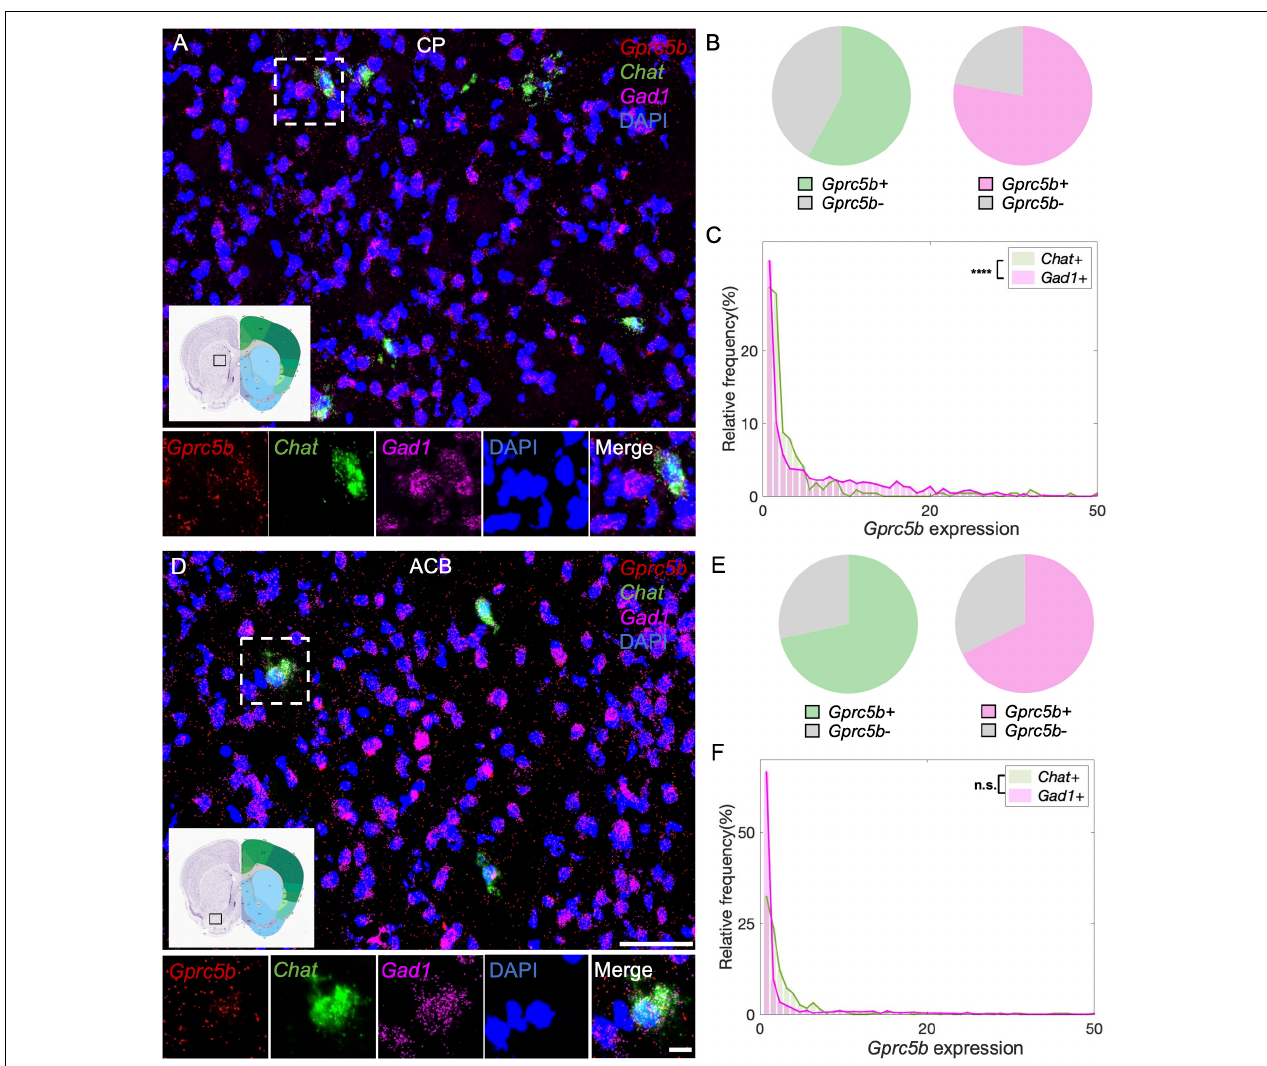
FIGURE 8 | Striatal Gprc5b mRNA distribution within cholinergic interneurons and GABAergic medium spiny neurons. Representative in situ hybridization images showing Gprc5b mRNA distribution in CP (A) and ACB (D) . Gprc5b is in red, cholinergic interneurons marked by Chat probe in green, GABAergic MSNs indicated by Gad1 probe in magenta, nuclei by DAPI in blue. Pie charts showing percentage of Gprc5b positive cells within cholinergic (green) and GABAergic (magenta) neuronal populations, across CP (B) and ACB (E) . (C) Frequency distribution graph depicting Gprc5b expression within cholinergic and GABAergic neurons in CP (Bin width = 1, sampled from 216 cholinergic interneurons and 1027 GABAergic neurons of 2–4 animals, p < 0.0001). (F) Frequency distribution graph illustrating Gprc5b expression within cholinergic and GABAergic neurons in ACB (Bin width = 1, sampled from 346 cholinergic interneurons and 1603 GABAergic neurons of 2–4 animals, p = 0.3592). Scale bar: 50 µ m; scale bar of magnified images: 10 µ m; reference brain images are retrieved from Allen brain atlas. Two-sided Wilcoxon–Rank sum test was conducted to compare expression within neuronal populations. **** p <